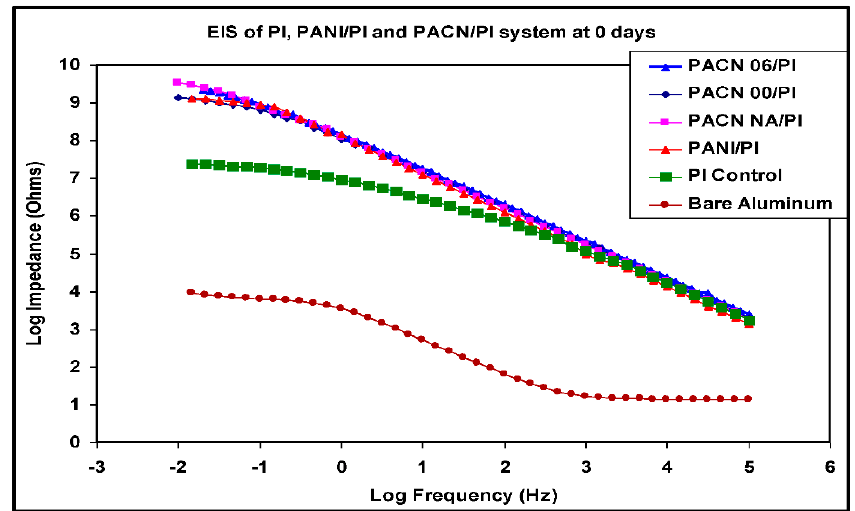
Figure 17. EIS spectra for freshly prepared (0 days) bare Al 2024-T3 substrate (bottom curve), neat PI (green squares), PANi/PI (red triangle), and the nanocomposite coatings PACN0/PI, PACNna/PI, PACN06/PI, and PANi/PI, respectively.